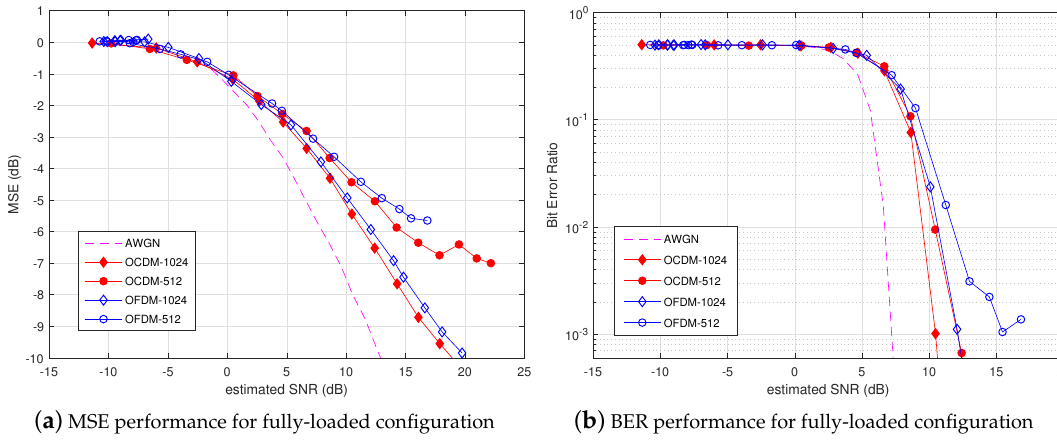
Figure 6. Performance comparison of fully-loaded OCDM and OFDM over the water tank channel.